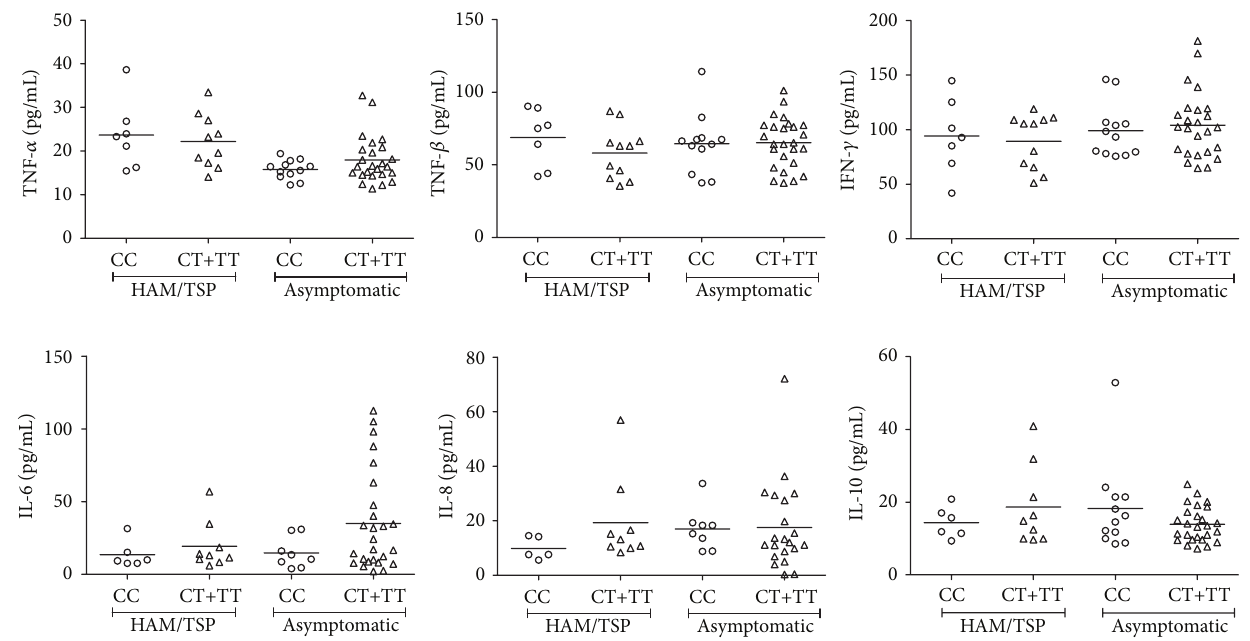
Figure 1: Cytokine serum levels according to the presence of the SNP rs12979860 in the HAM/TSP and asymptomatic groups.